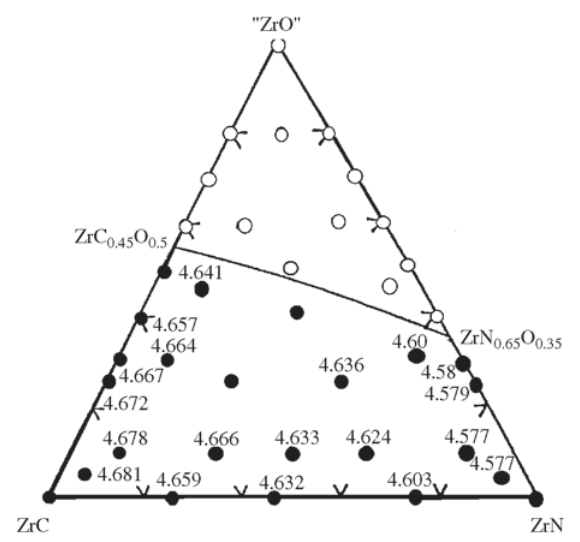
Figure 2. Pseudoternary diagram of the ZrN – ZrO – ZrC system at 1600 °C (from Constant et al. ) 2 . The unit-cell parameters a Zr(C,N,O) are indicated (cid:122) monophase zone and (cid:129)(cid:129)(cid:129)(cid:129)(cid:129) polyphase